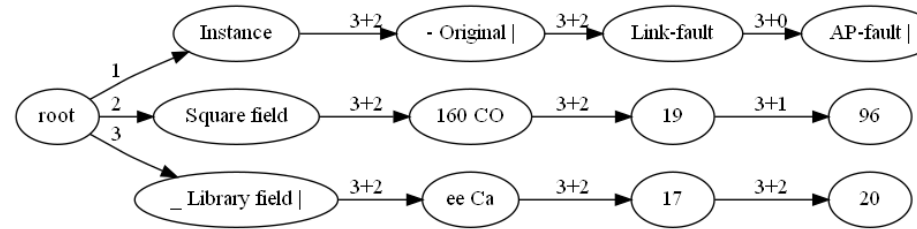
Figure 20. Tree for scanned table image 3.